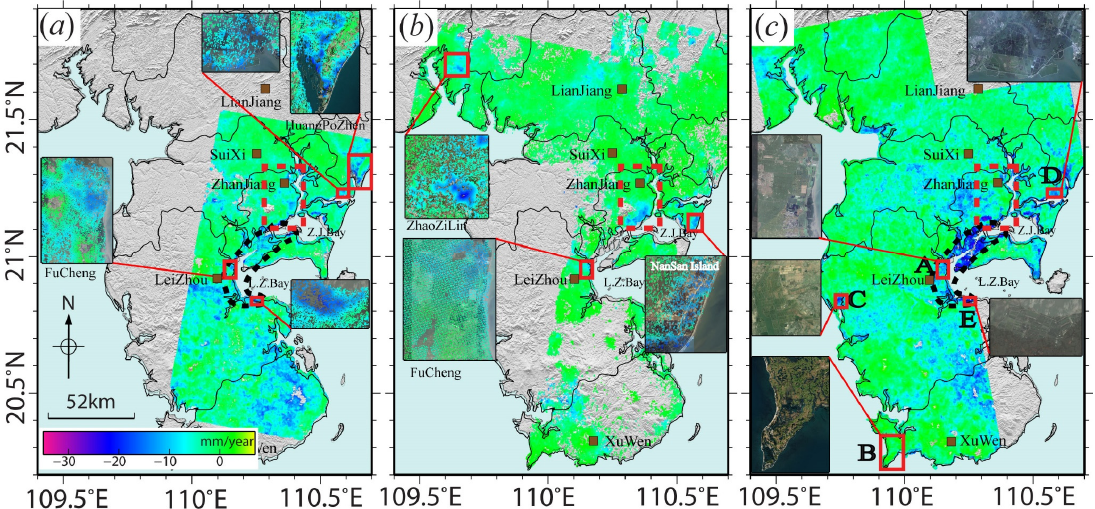
Figure 5. Average subsidence velocity of the LZP from 1992 to 2010. ( a ) Mean velocity map of JERS from October 1992 to September 1998; ( b ) mean velocity map of ENVISAT from October 2003 to May 2007; ( c ): mean velocity map of ALOS1 from December 2006 to July 2010. Positive velocities (yellow) represent uplift, while the negative values (purple) indicate subsidence. Brown squares are representative of city’s locations. The red dashed rectangle is the representative subsidence area covering Zhanjiang city shown in Figure 7. Rectangle A, B, C, D, and E in Figure 5c are five representative areas in Figure 10. The locations are abbreviated as follows: the Leizhou Bay (L.Z.Bay), the Zhanjiang Bay (Z.J.Bay).